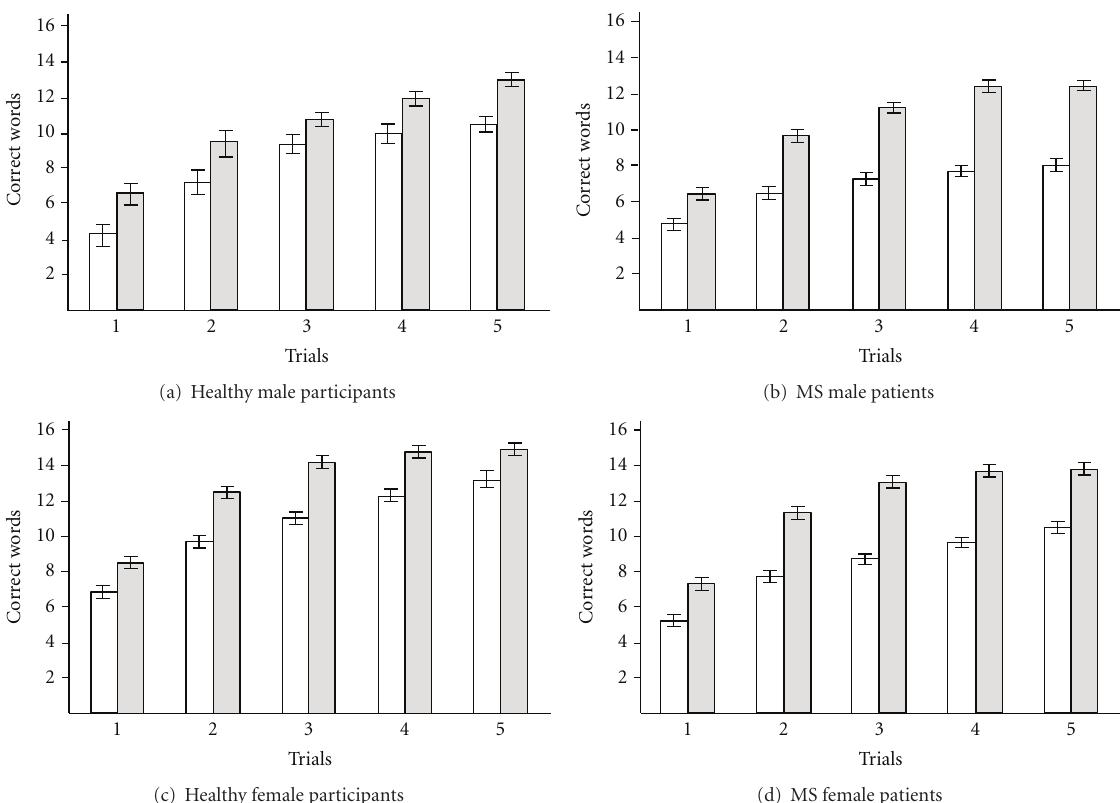
Figure 1: Cluster analysis of the CVLT-II measures trials 1–5. (a) Healthy male participants, cluster referring to lower memory functioning (9 cases) and cluster referring to higher memory functioning (11 cases). Comparing the values for every trial with a t -test for independent samples revealed that the same trial values di ff ered between cluster referring to lower memory functioning and cluster referring to higher memory functioning ( P < . 05) with the exception of Trial 3 ( P = . 075). (b) MS male patients, cluster referring to lower memory functioning (46 cases) and cluster referring to higher memory functioning (53 cases). Comparing the values for each of the five trials with a t -test for independent samples, revealed significant di ff erences between cluster referring to lower memory functioning and cluster referring to higher memory functioning for each trial ( P ≤ . 001). (c) Healthy female participants, cluster referring to lower memory functioning (38 participants) and cluster referring to higher memory functioning (40 participants). Comparing values for every trial with a t -test for independent samples revealed that the same trial values di ff ered between cluster referring to lower memory functioning and cluster referring to higher memory functioning ( P < . 001). (d) MS female patients, cluster referring to lower memory functioning (133 patients) and cluster referring to higher memory functioning (133 patients). Comparing values for every trial with a t -test for independent samples revealed that the same trial values di ff ered between cluster referring to lower memory functioning and cluster referring to higher memory functioning ( P < . 001). Cluster referring to lower memory functioning—white bar, cluster referring to higher memory functioning—gray bar. Each bar represents mean ±